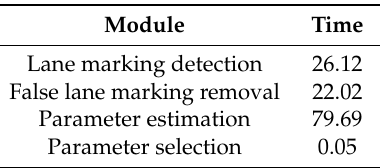
Table 5. Execution time